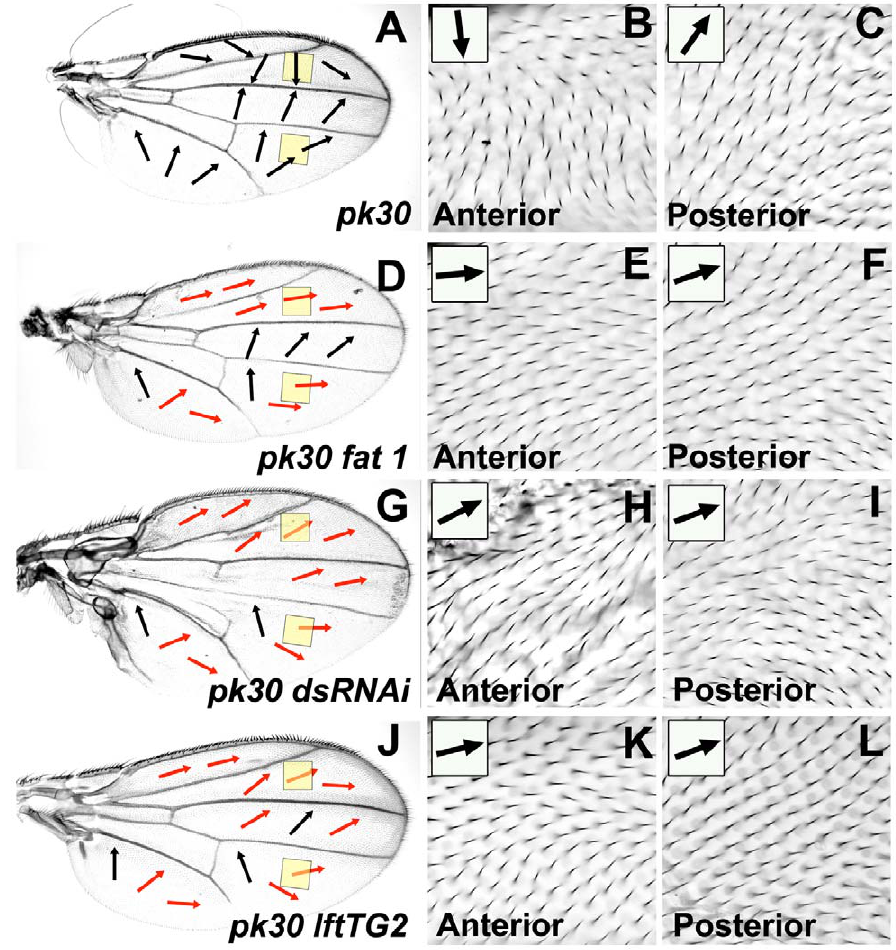
Figure 4. Reduced Ft/Ds pathway gene activity modifies the pk pk hair polarity phenotype. All micrographs are of the female dorsal wing surface. Arrows indicate local hair polarity, red arrows indicate where local hair polarity differs from that seen on a pk pk30 homozygous wing. (A) pk pk30 homozygous wing. (B) Detail of anterior pk pk30 homozygous wing (anterior yellow shaded region in (A)). (C) Detail of posterior pk pk30 homozygous wing (posterior yellow shaded region in (A)). (D) ft 1 , pk pk30 homozygous wing. (E) Detail of anterior ft 1 , pk pk30 homozygous wing (anterior yellow shaded region in (D)). (F) Detail of posterior ft 1 , pk pk30 homozygous wing (posterior yellow shaded region in (D)). (G) MS1096-gal4 ; UAS-ds(IR) , pk pk30 / pk pk30 wing. (H) Detail of anterior MS1096-gal4 ; UAS-ds(IR) , pk pk30 /pk pk30 wing (anterior yellow shaded region in (G)). (I) Detail of posterior MS1096-gal4 ; UAS-ds(IR) , pk pk30 /pk pk30 wing (posterior yellow shaded region in (G)). (J) lft TG2 , pk pk30 homozygous wing. (K) Detail of anterior lft TG2 , pk pk30 homozygous wing (anterior yellow shaded region in (J)). (I) Detail of posterior lft TG2 , pk pk30 homozygous wing (posterior yellow shaded region in